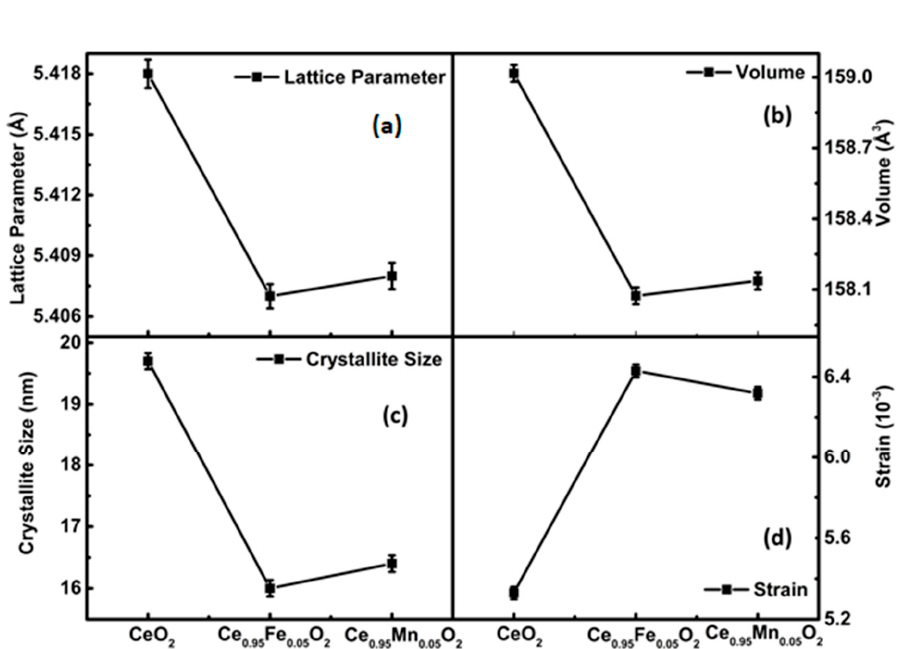
Figure 2. The variation of ( a ) lattice parameter; ( b ) unit cell volume; ( c ) crystallite size and ( d ) strain obtained for undoped and CeXO 2 (X: Fe, Mn) nanoparticles.